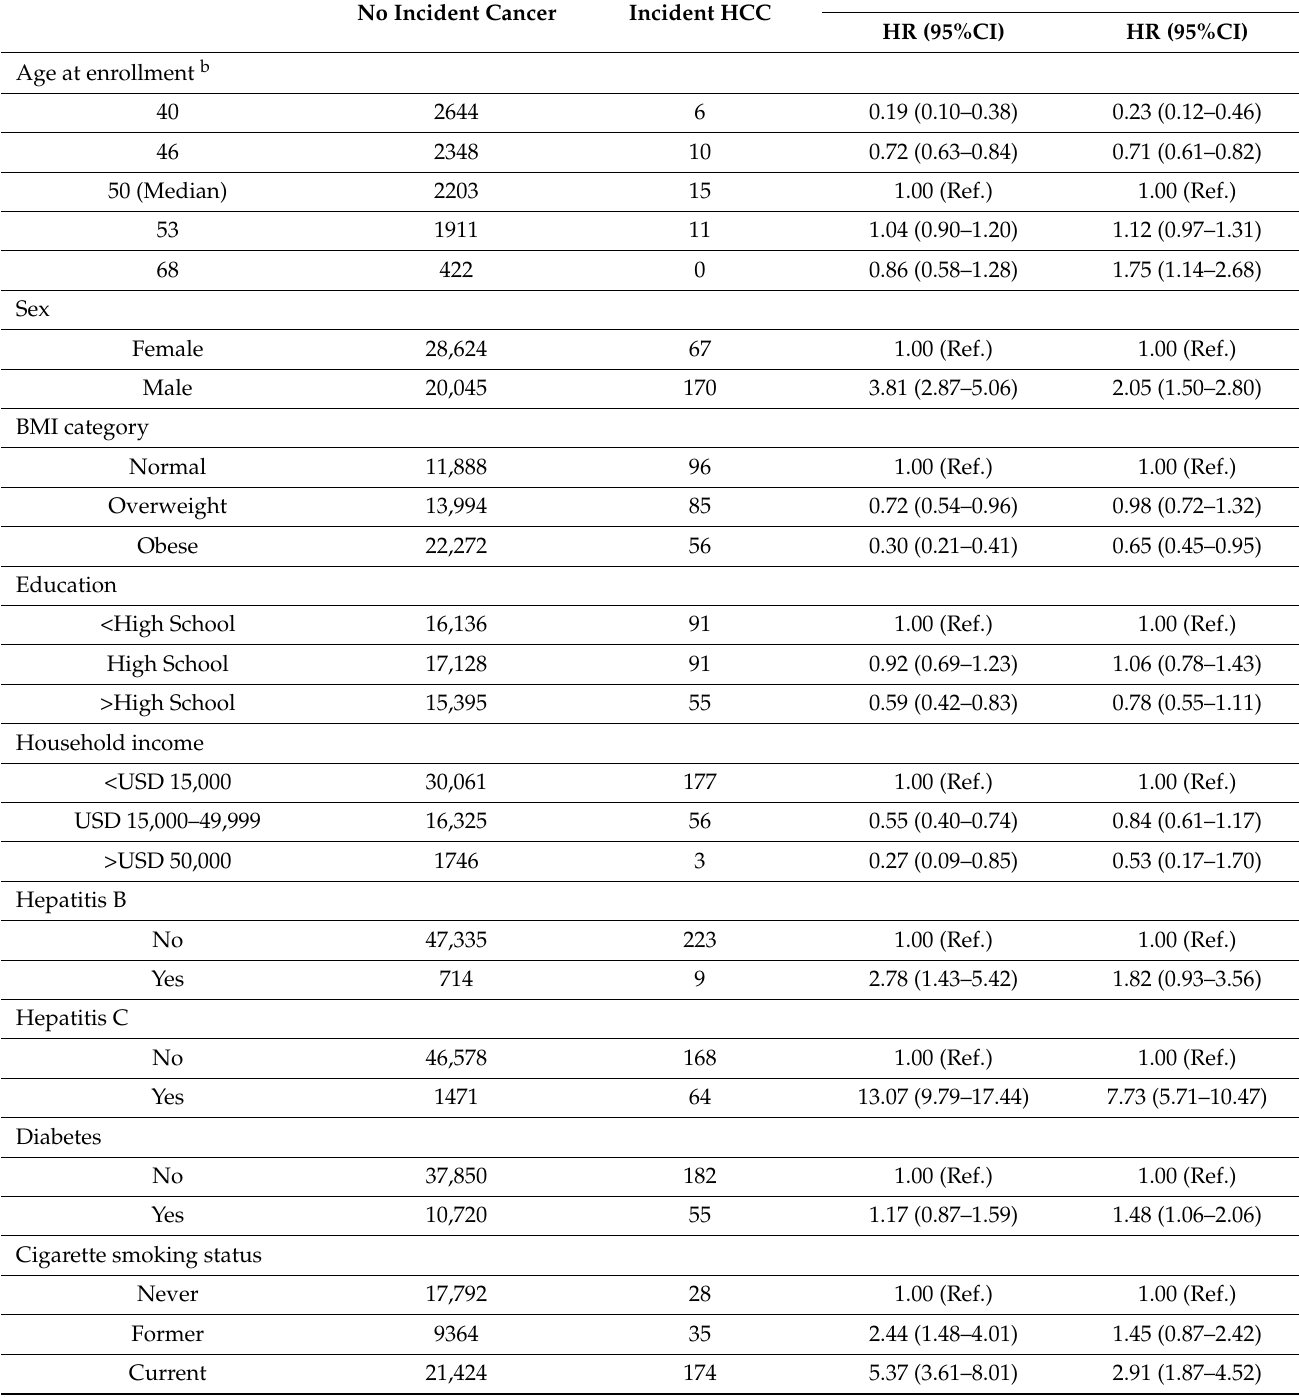
Table 2. Univariate and multivariable hazard ratios (HR) and 95% confidence intervals (95%CI) for risk factors associated with hepatocellular carcinoma (HCC) incidence among African